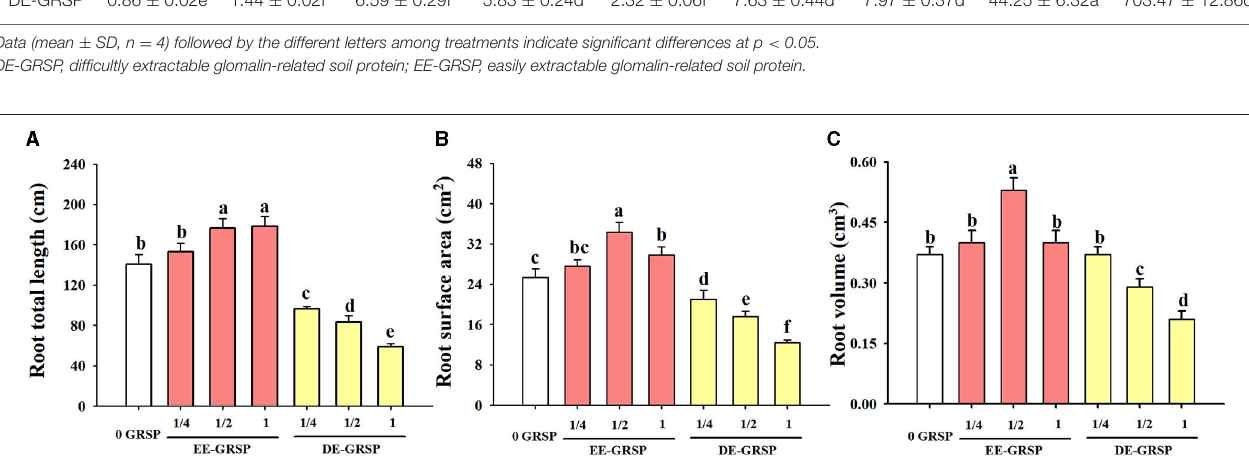
FIGURE 4 | Effects of exogenous EE-GRSP and DE-GRSP on root total length (A) , root surface area (B) , and root volume (C) of trifoliate orange. Data (mean ± SD, n = 4) followed by different letters above the bars indicate significant differences ( p < 0.05). DE-GRSP, difficultly extractable glomalin-related soil protein; EE-GRSP, easily extractable glomalin-related soil